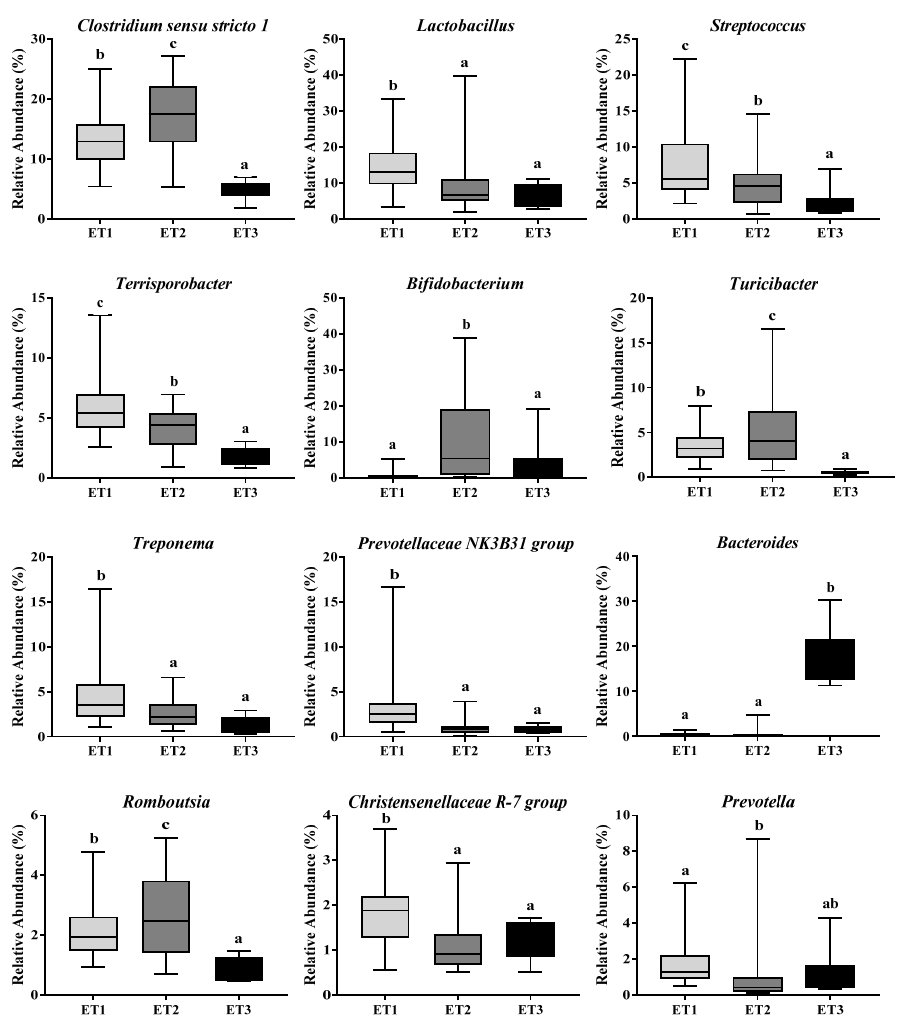
Figure 3. Differentially abundant bacterial genera in three enterotypes. The relative abundances of the 12 most abundant genera in three ETs were illustrated. Different letters indicate a significant difference ( p < 0.05) with the 95% confidence interval. Abbreviation: ET, enterotype.